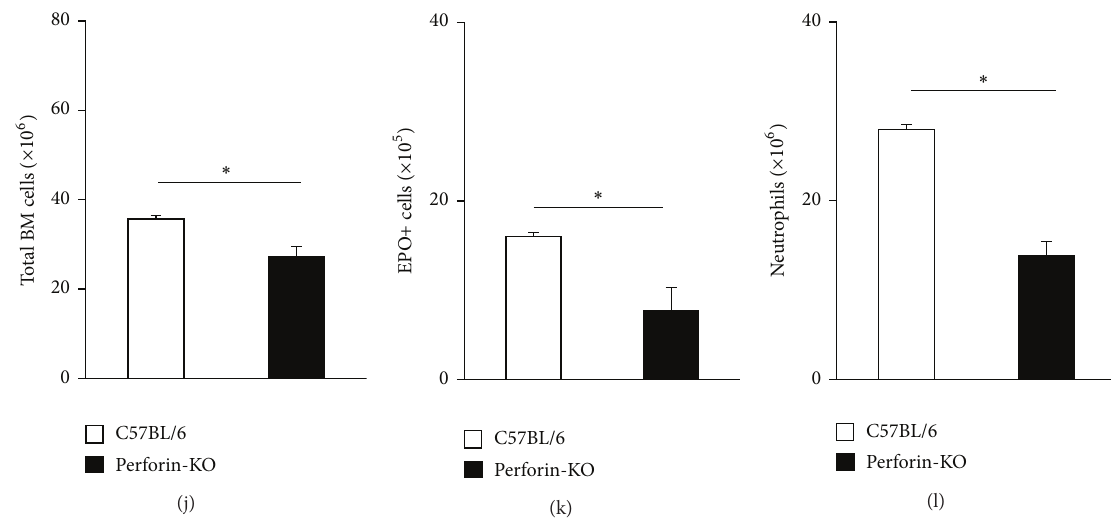
Figure 1: Total and granulocyte counts in freshly harvested bone-marrow of Pfp mice and B6 wild-type controls. Data are Mean + SEM of the counts of total nucleated cells ((a), (d), (g), (j)), EPO+ cells ((b), (e), (h), (k)), and neutrophils ((c), (f), (i), (l)) in C57BL/6 (white bars) and perforin-deficient (Pfp, black bars) bone-marrow. (a)–(c) No matching of age or weight between mutant and control groups; (d)–(f) groups matched by weight (median = 21 g, range 19 g–23 g); (g)–(i) groups matched by age (all at 12 weeks); (j)–(l) groups matched by weight and age. For B6 and Pfp mice, respectively, in (a), 𝑛 = 44 and 𝑛 = 48 ; in (b), 𝑛 = 27 and 𝑛 = 30 ; in (c), 𝑛 = 27 and 𝑛 = 24 ; in (d) and (e), 𝑛 = 6 for both; in (f), 𝑛 = 5 and 𝑛 = 6 ; in (g), (h), and (i), 𝑛 = 7 for both. In (j), (k), and (l), 𝑛 = 3 for both. ∗ Significant differences between the indicated